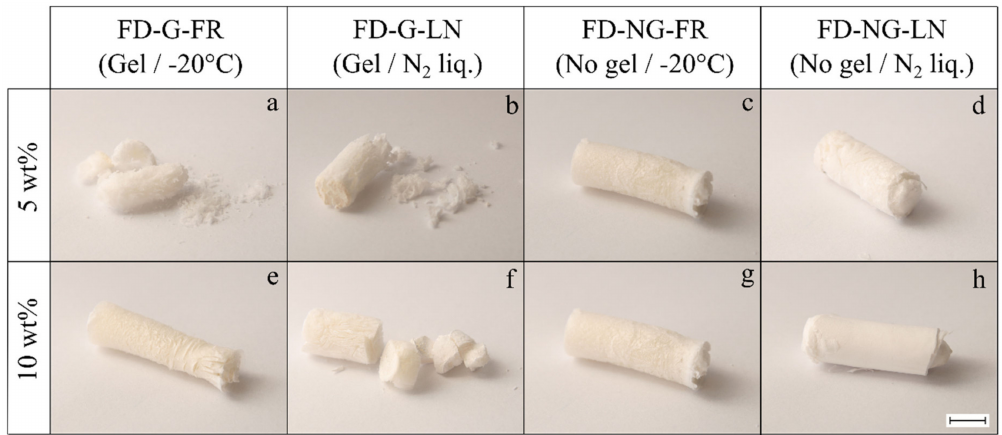
Figure 1. Physical appearance of freeze-dried starch samples (“FD”) derived from 5 and 10 wt.% starch suspensions corresponding respectively to the first and second row of pictures ( a – d ) and ( e – h ). Samples gelled and retrograded at +6 ◦ C overnight are denoted as “FD-G” (pictures ( a , b , e , f )), non-gelled samples are denoted as “FD-NG” (pictures ( c , d , g , h )). Prior to freeze-drying the samples were frozen at − 20 ◦ C in a freezer (“FR”—pictures ( a , e , c , g )) or in liquid nitrogen (“LN”—pictures ( b , f , d , h )). Sublimation was performed at 0.045 mbar (cold trap temperature − 49 ◦ C) for 96 h. The scale bar corresponds to approximatively 1 cm.